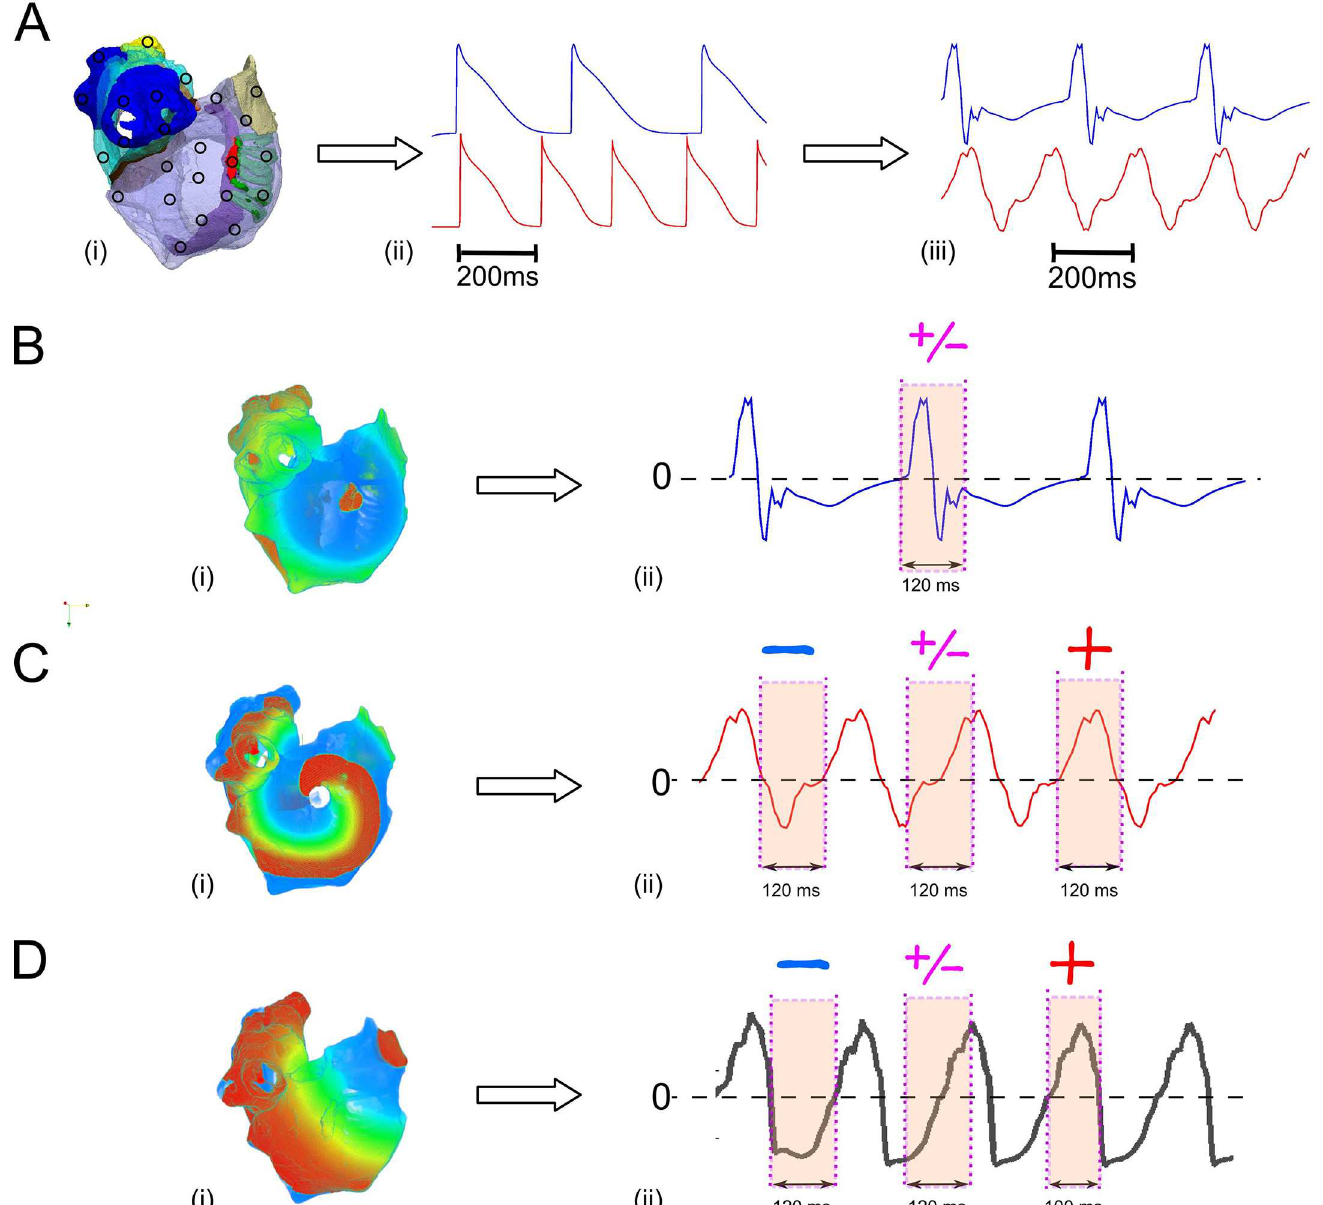
Fig 2. Illustration of different atrial activation associated with different body surfaceatrial waveform morphology. (A) Different stimulated points (circle) and tip of re-entry across the surface of the atria (i), atrial action potentials (ii) and their corresponding body surface atrial-waves at different excitationrates (iii): top 3Hz; bottom 5Hz. (B) Snapshotof atrial activationat control conditions at a fast rate, (i) and its corresponding ECG exhibitingdistinct P-wave in lead V1 (ii). (C) Snapshot of atrial activationwhen the tip of the re-entry is locatedin the SAN (i), and its corresponding atrial waves of lead V1 (ii). (D) Snapshot of atrial activationwith the focal ectopic activity locatedin the right atrial appendage(RAA) (i) and the corresponding atrial waves of lead V1 (ii). A red sign representsa positive polarity in the atrial-wave (magenta/shaded area), the blue sign is a negative polarityand a purplesign representsa